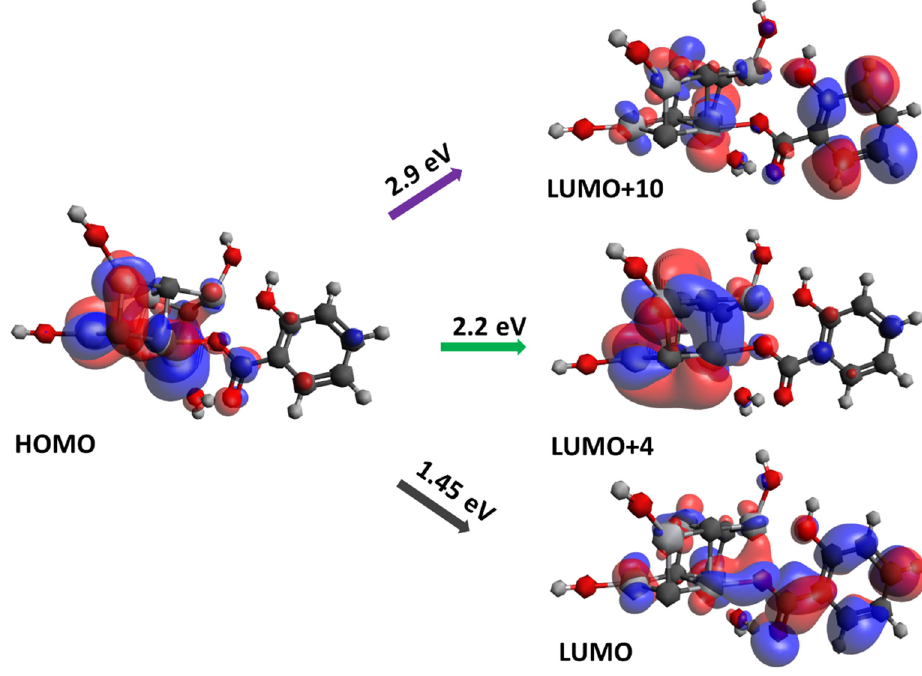
Figure 9. Calculated (B3LYP/LanL2DZ) molecular orbitals of salicylic acid–MXene complex and required transition energy.